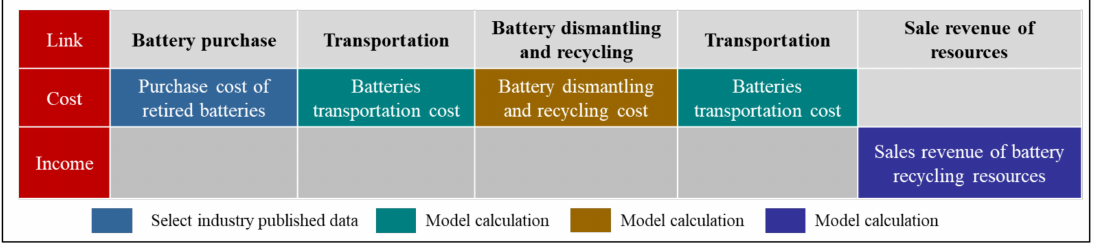
Figure 8. Block diagram of the economic benefit evaluation model for battery